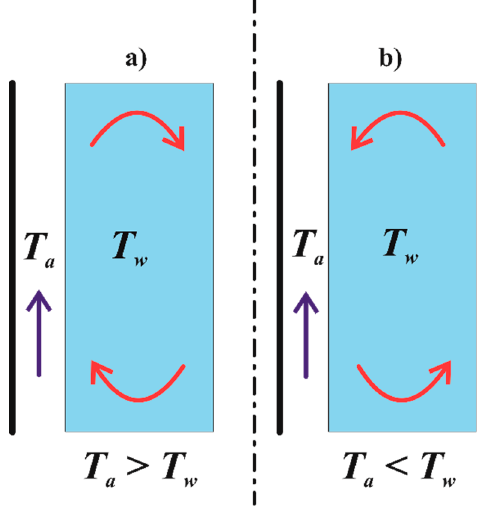
Figure 2. Charging ( a ) and discharging; ( b ) processes of the system.